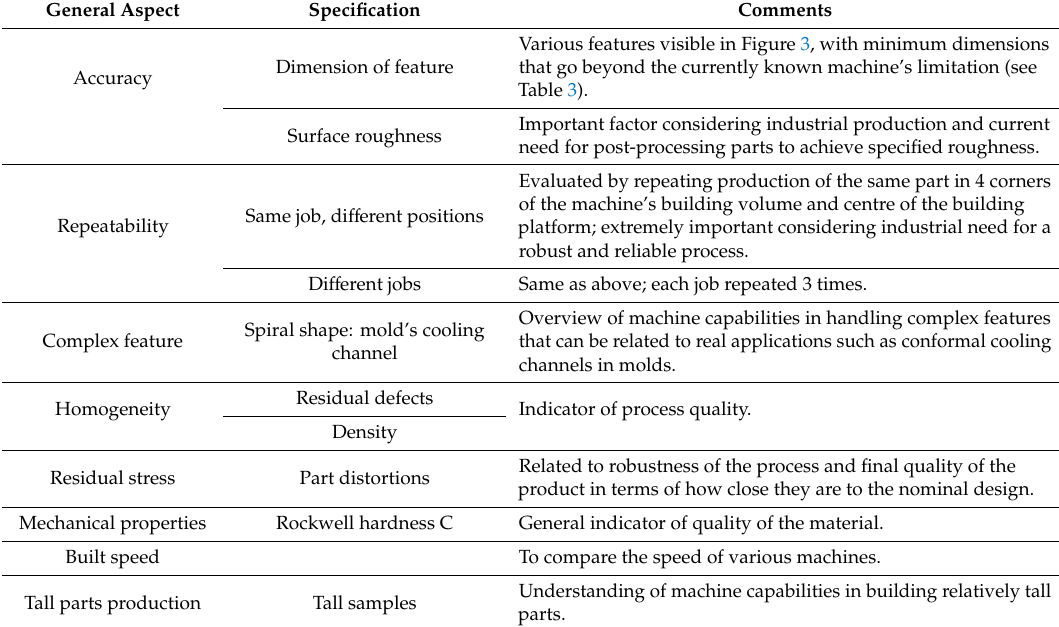
Table 2. Investigation criteria of benchmarking.